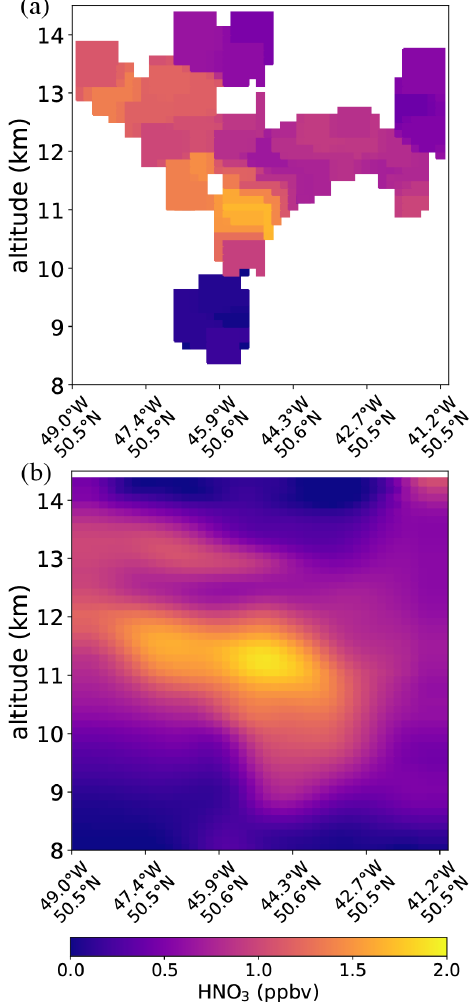
Figure 15. (a) HNO 3 volume mixing ratios on a vertical cut in- side the hexagonal flight pattern based on back-traced 9 October measurements. (b) HNO 3 volume mixing ratios from the 7 October tomographic 3-D retrieval on the same vertical cut for